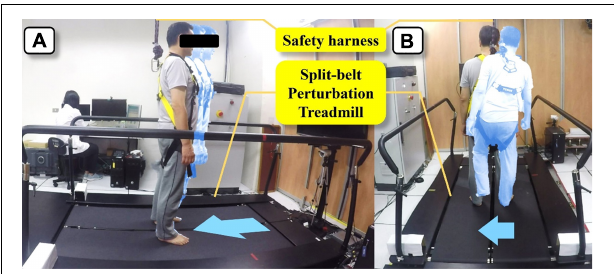
FIGURE 3 | Perturbation-based balance training using a split-belt perturbation treadmill. (A) Training during standing. (B) Training during walking.